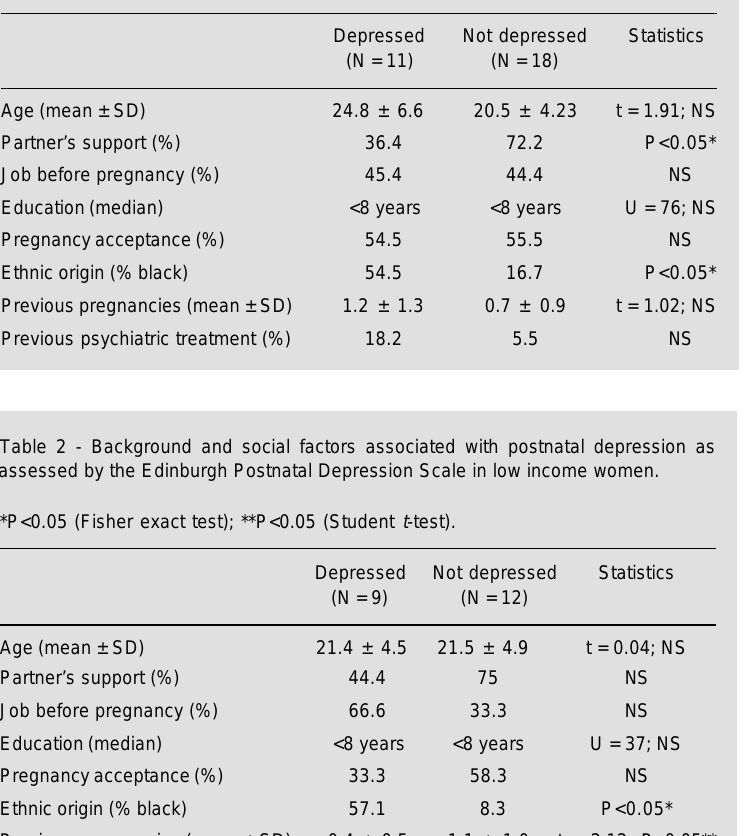
Table 1 - Background and social factors associated with prenatal depression as assessed by the Edinburgh Postnatal Depression Scale in low income women. *P<0.05 (Fisher exact test).